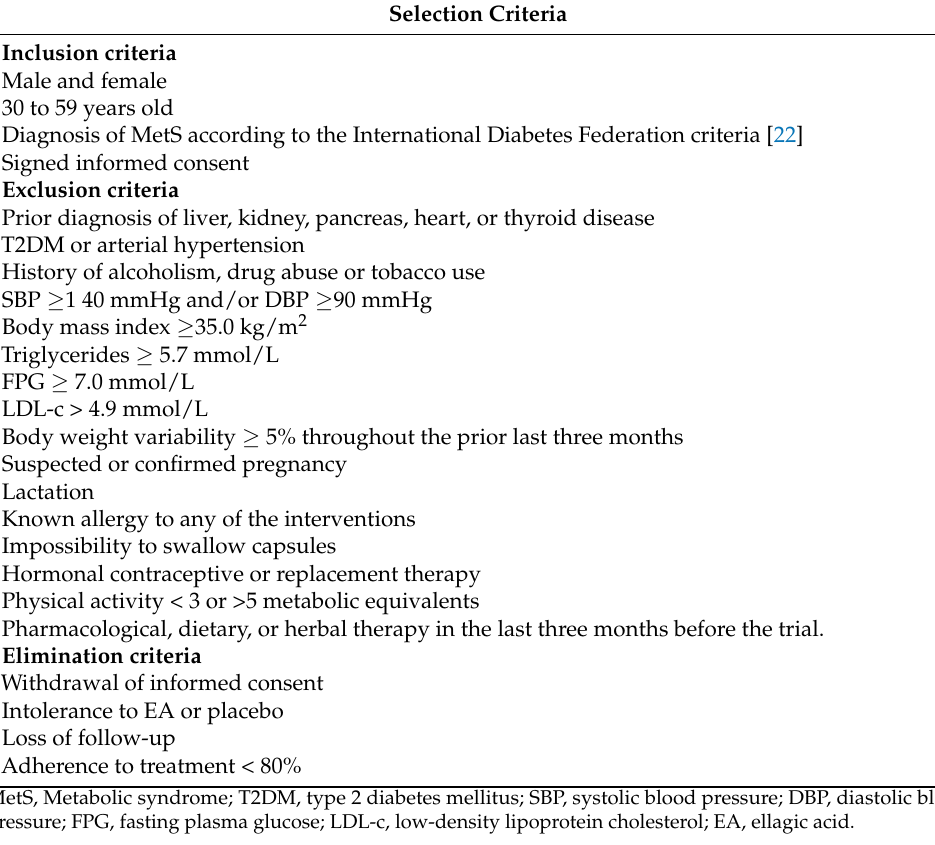
Table 1. Inclusion, exclusion, and elimination